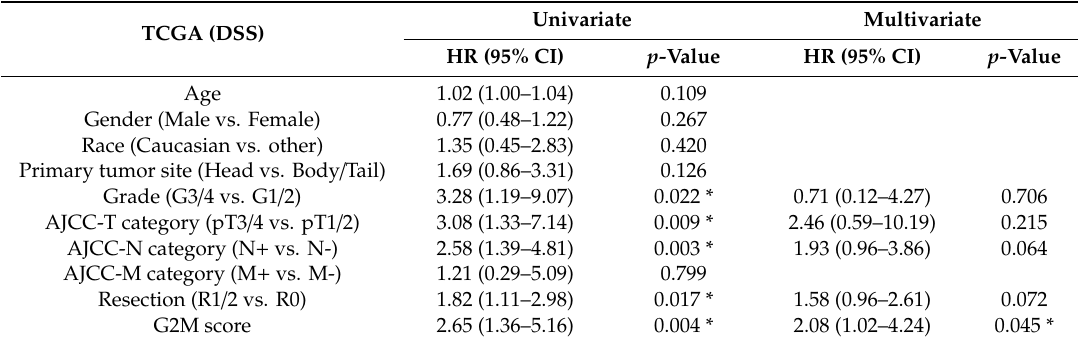
Table 2. Survival analyses of the G2M pathway score and other factors in the TCGA cohort. Univariate TCGA (DSS)